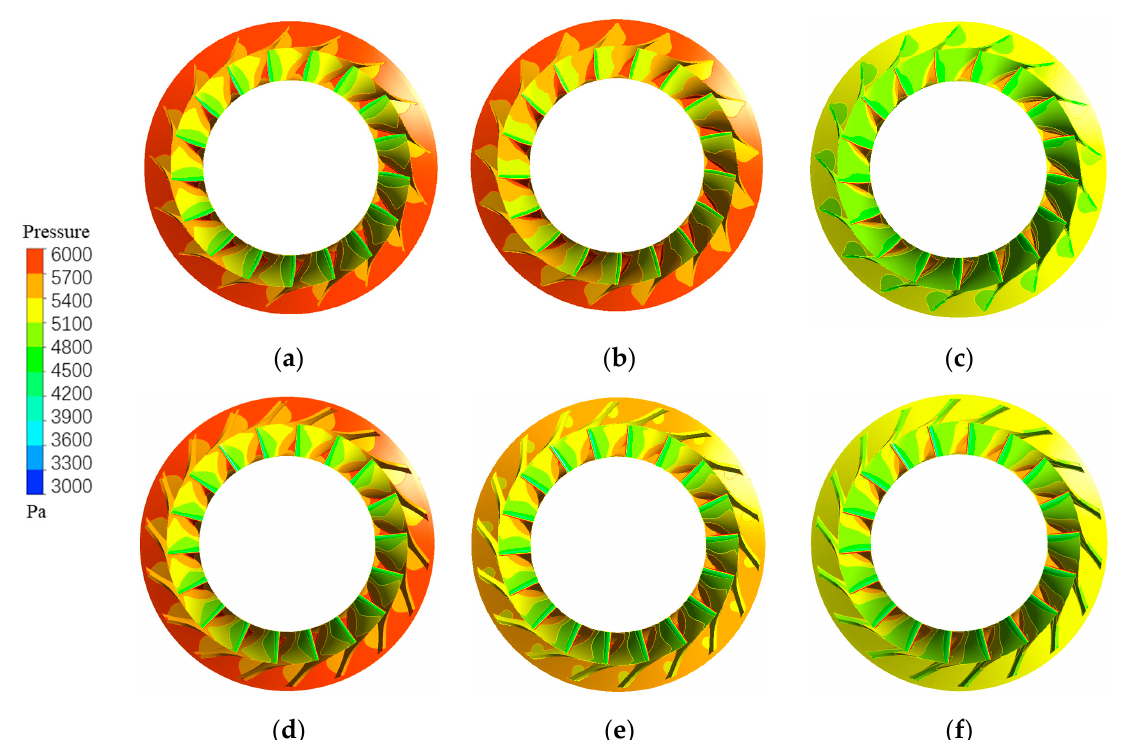
Figure 6. Static pressure distributions in impellers of original and optimized fans: ( a ) optimize impeller 0.8 Q; ( b ) optimize impeller Q; ( c ) optimize impeller 1.2 Q; ( d ) original impeller 0.8 Q; ( e ) original impeller Q; ( f ) original impeller 1.2 Q.